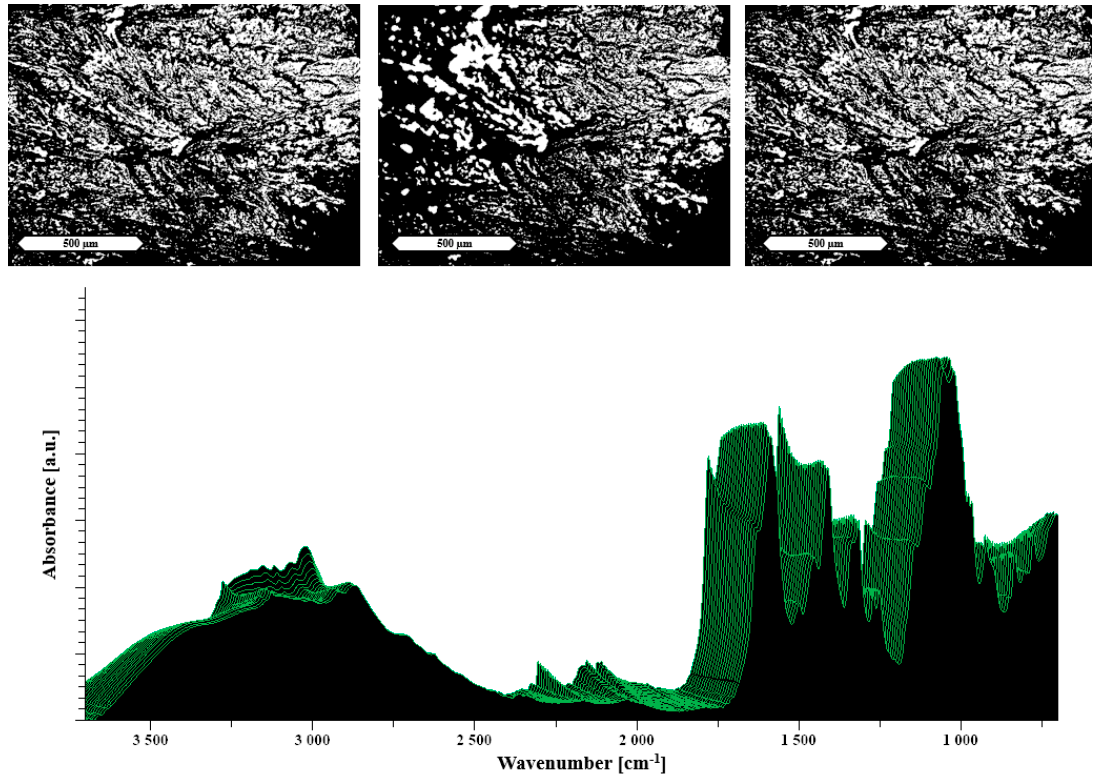
Figure 5. The images at the top show HSM images of histidine/NaCMC evaporated films taken at RT, 90 °C and 130 °C (from left to right). At the bottom, a temperature-resolved FTIR spectrum is shown. The displayed scale bar refers to 500 μ m. Each spectrum was measured at temperatures from 30 °C (measured first in the front) to 130 °C (in the back) by increasing steps of 5 °C.